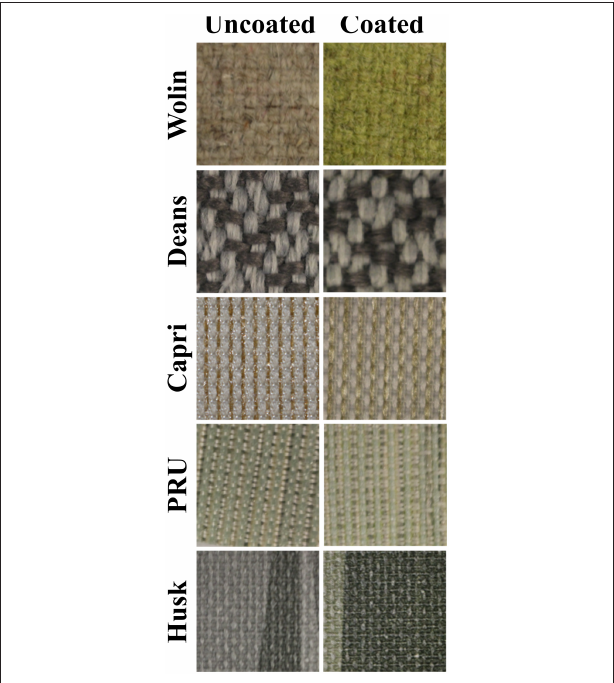
FIGURE 2 | Photographic images of Vescom materials without (left) and with (right) the SbQ-PVA/ZnTMPyP 4 + coating.